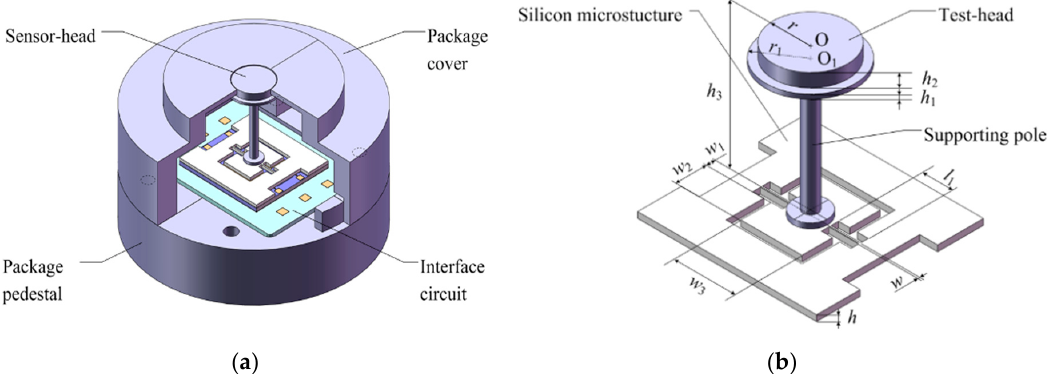
Figure 1. Sensor optimization. ( a ) Overall structure; ( b ) Sensor-head.